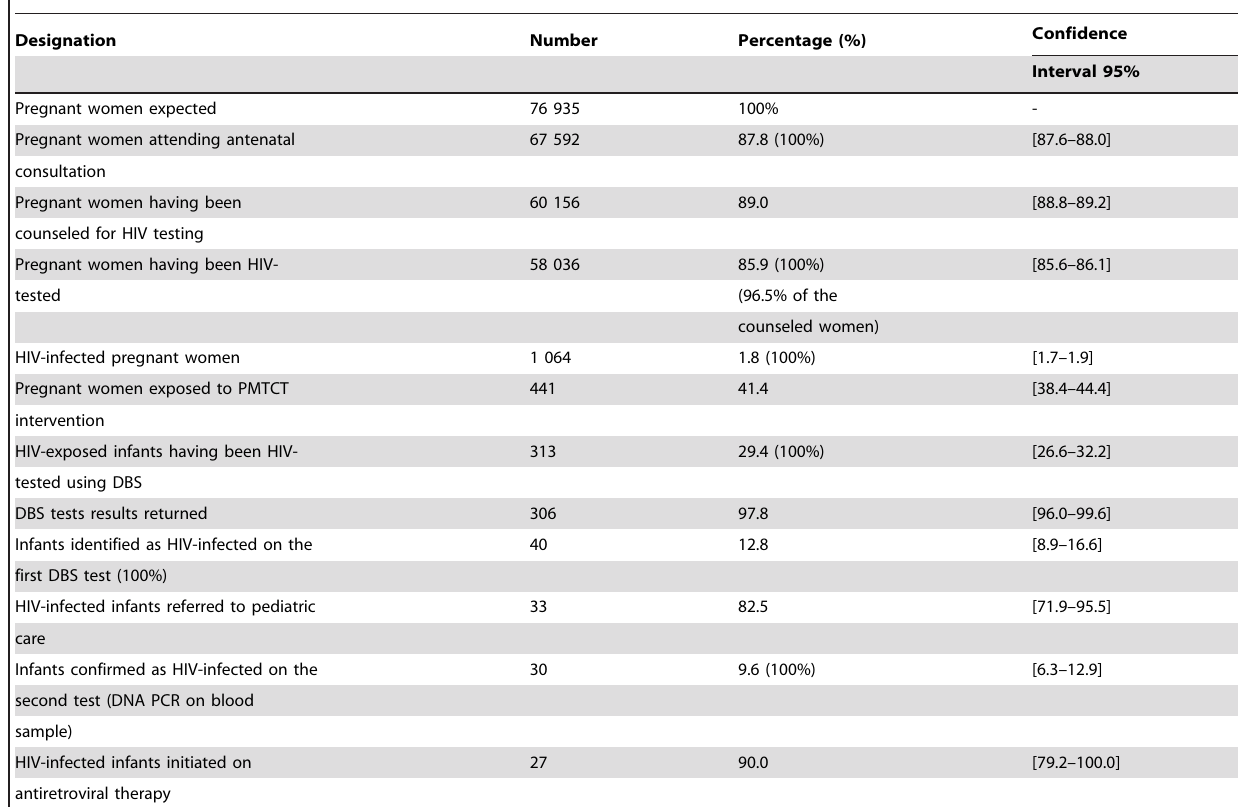
Table 2. The PMTCT cascade until HIV pediatric care in Ouagadougou,